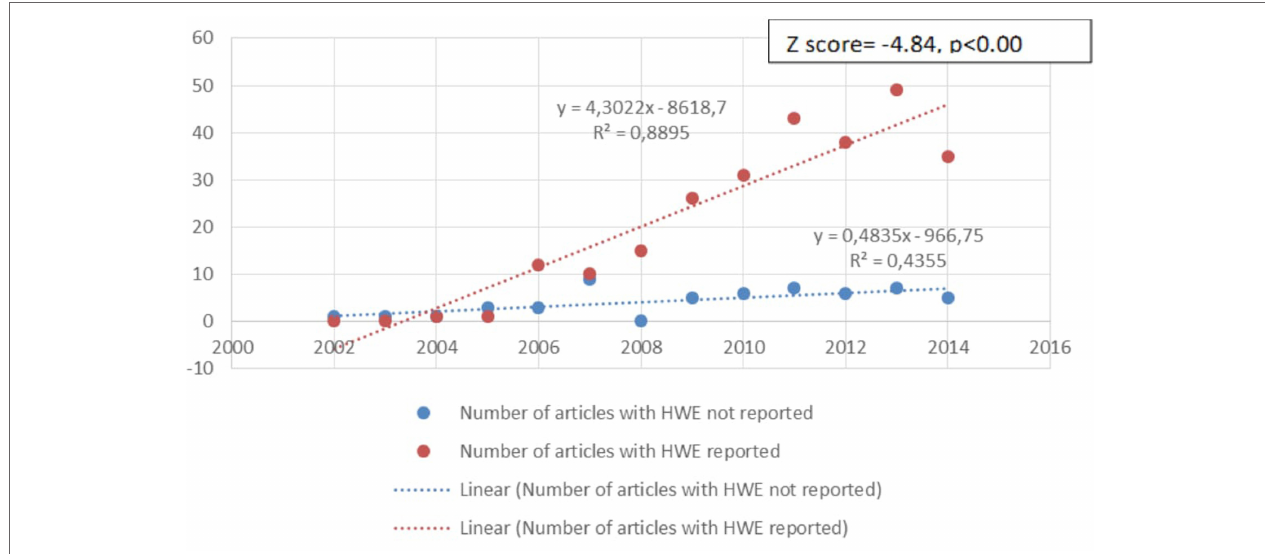
FiGURe 11 | Change over time in the quality of genotyping [reported Hardy–Weinberg equilibrium (HWE)] used in studies. The number of articles that reported HWE was increasing over the years. The first study to report HWE was in 2004. In recent years only 12.5% (2014 n = 5/40, 2015 n = 7/56) of the studies did not report